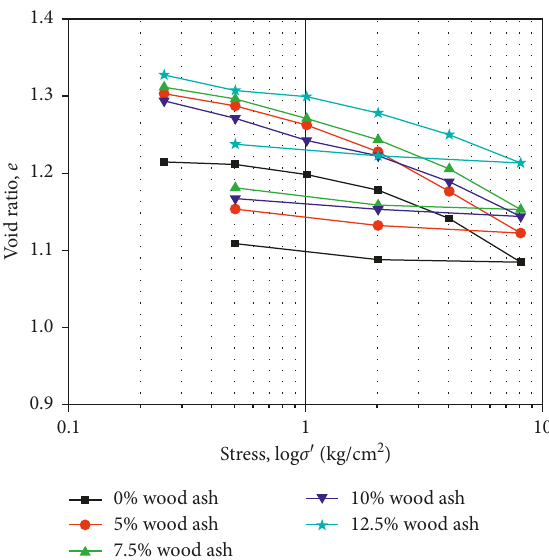
Figure 6: The Mohr–Coulomb failure